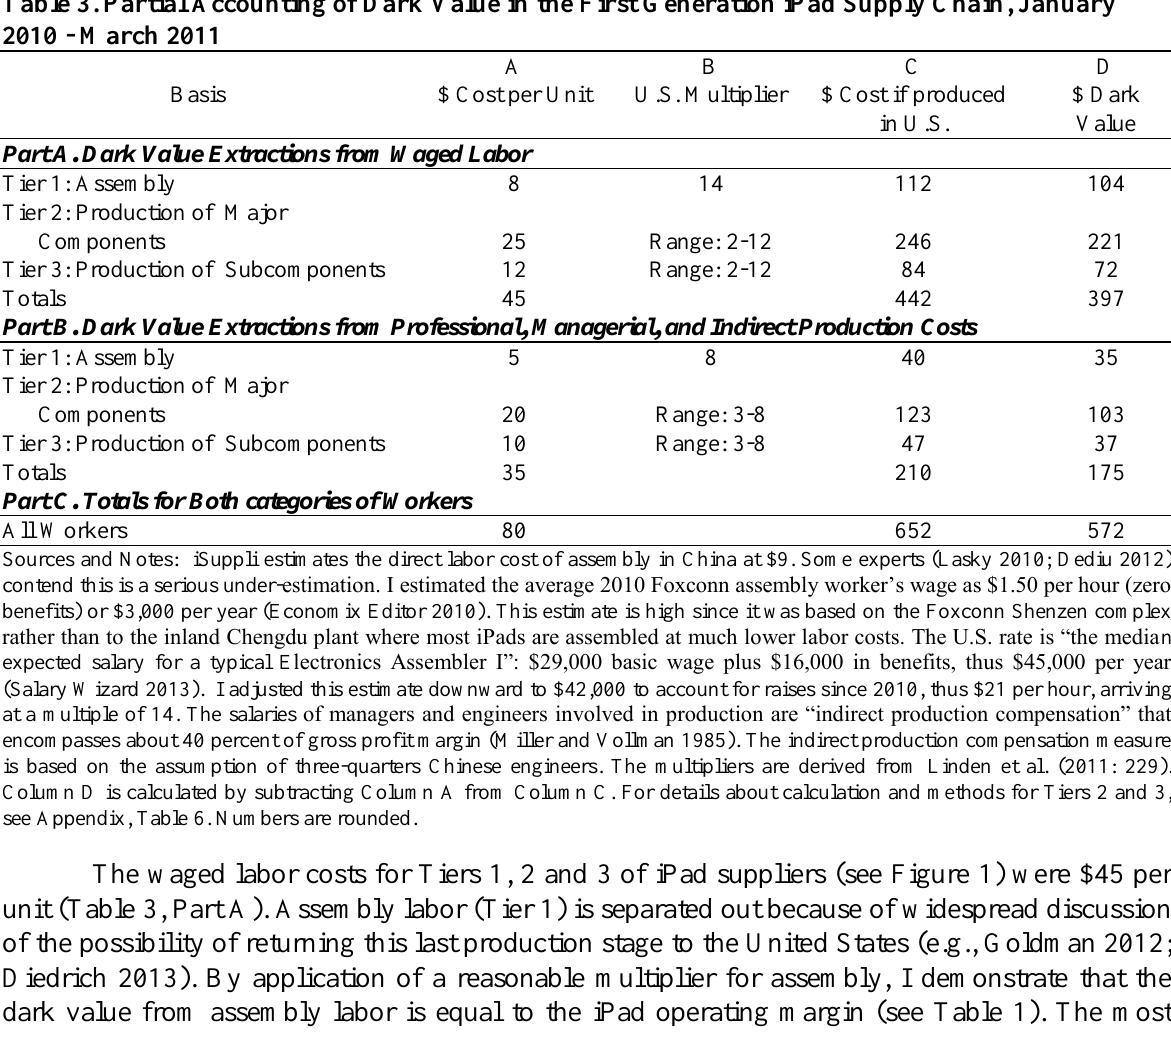
A B C D $ Cost per Unit U.S. Multiplier $ Cost if produced $ Dark in U.S.